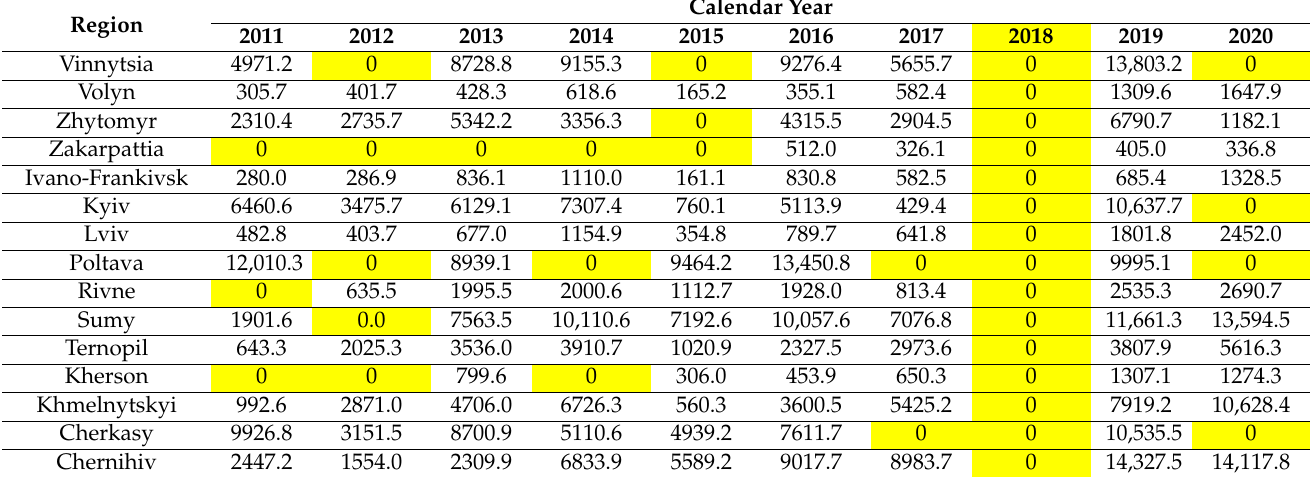
Table 4. Cost ( C w ) of disposal of corn waste for the production of clean energy, thousand EUR.